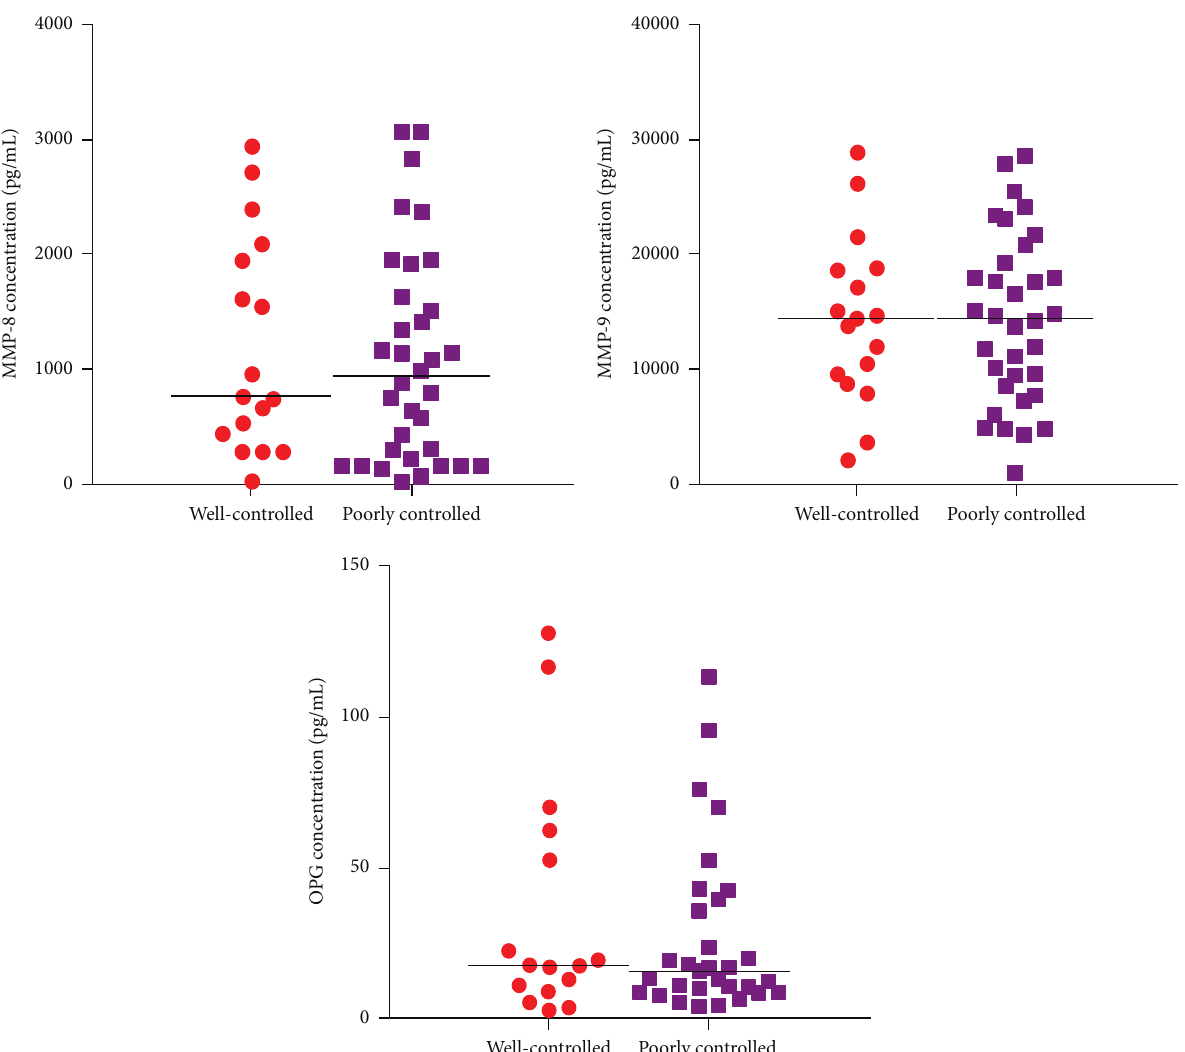
Figure 2: Distribution of salivary MMP-8, MMP-9, and OPG concentrations (pg/mL) in well-controlled ( 𝑛 = 37 ) and poorly controlled ( 𝑛 = 17 ) type 2 diabetes